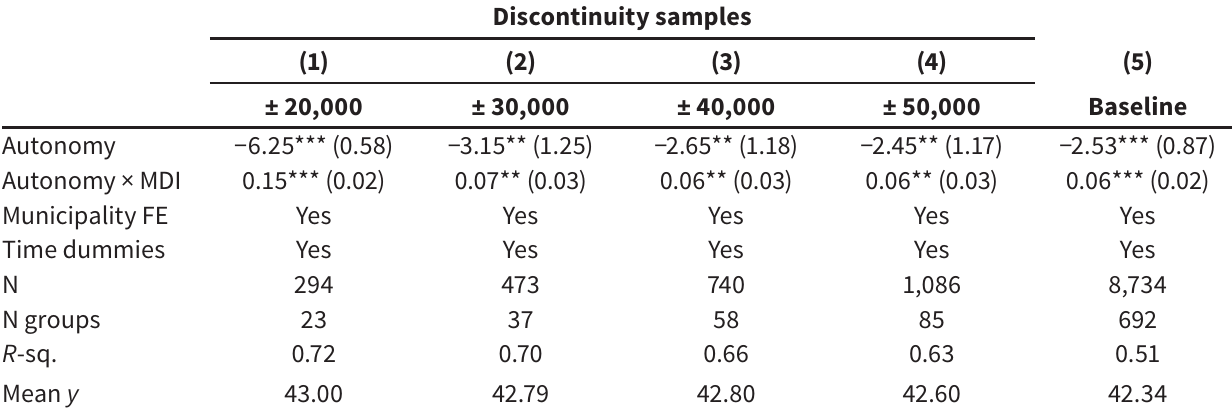
Results on “discontinuity samples” around the autonomy threshold Discontinuity